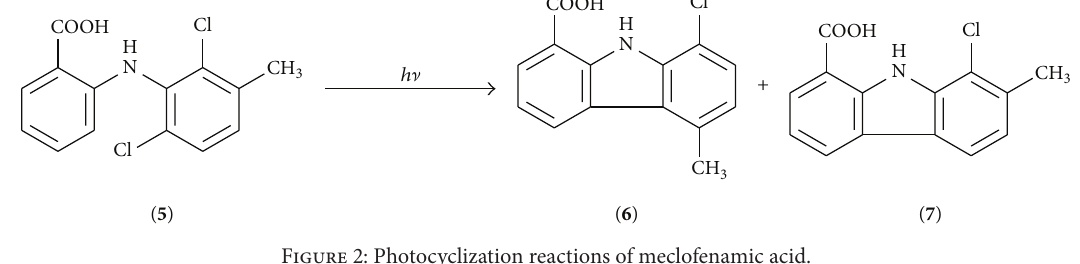
Figure 2: Photocyclization reactions of meclofenamic acid.